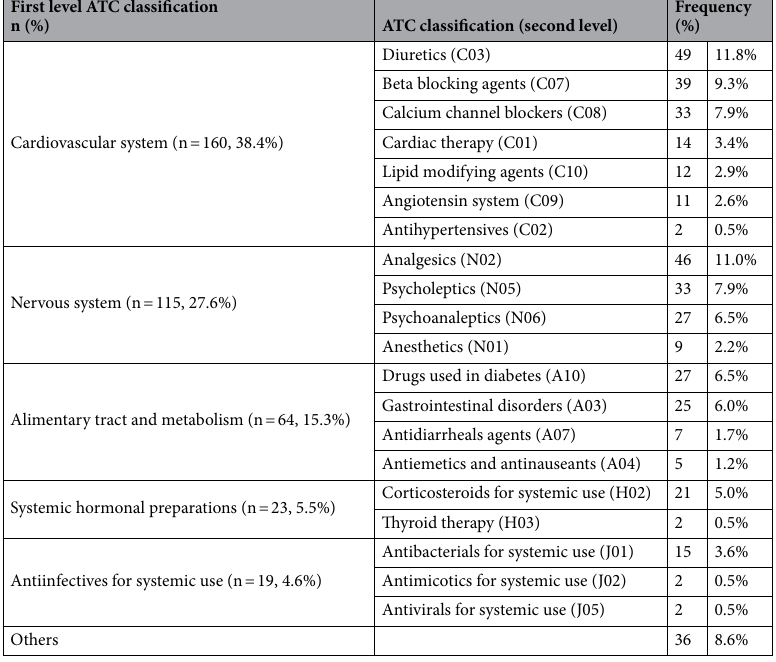
Table 2. Real DDIs between experimental COVID-19 therapies and comedication according ATC.